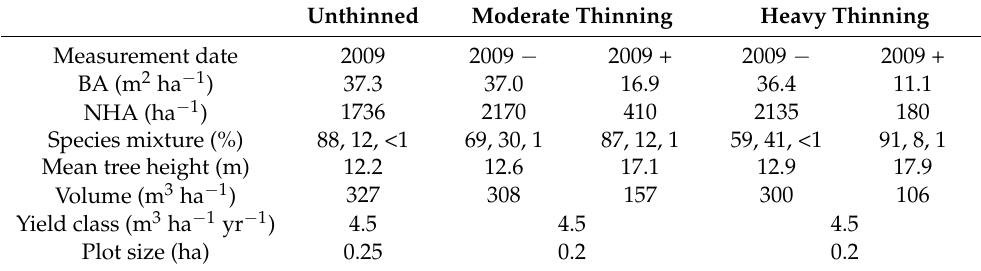
Table 1. We calculated stand-level increment and losses (BA2 is zero) for the two periods with remeasurements (2009–2014 and 2014–2019, each spanning 5 years), after Equation (1). BA_inc = (BA2 − BA1)/5 (1) Table 1. Stand structure of three stands in year 2009. For thinned stands we show condition before thinning (“2009 − “) and after thinning (“2009 +“). BA is basal area at breast height (1.3 m above ground) and NHA is stem density. Species mixture represents tree species proportions in percent of BA. Separated by commas, the first numbers represent sessile oak, Quercus petraea (Matt.) Liebl. (pooled with Turkey oak, Quercus cerris L.), the second number European hornbeam, Carpinus betulus L., and the third number European beech, Fagus sylvatica L. Volume is stem volume using the Austrian form factor functions [32]. Yield class is the cumulative increment at age 100 years using Austrian yield tables [33]. Unthinned Moderate Thinning Heavy Thinning Measurement